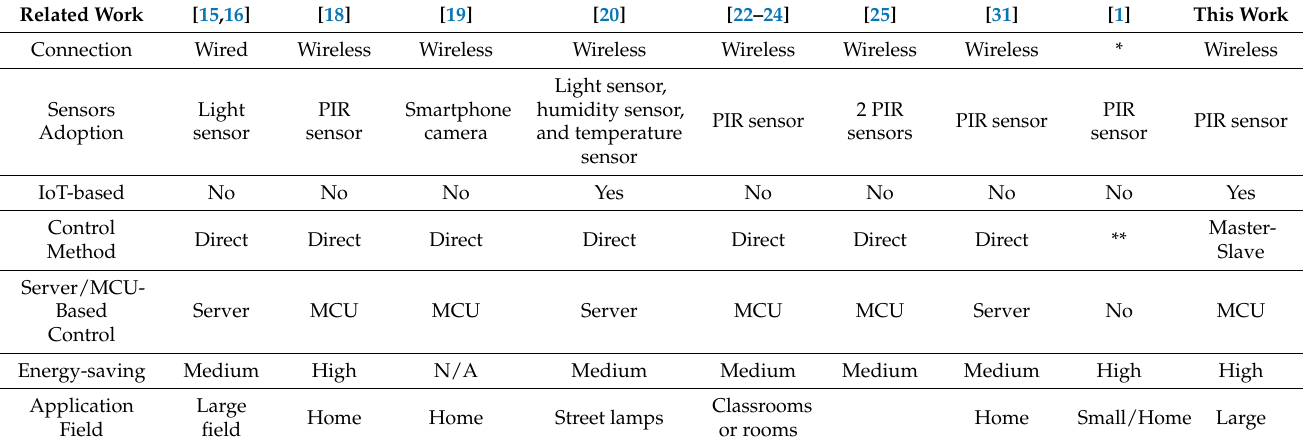
Table 1. A comparison of related works with the proposed system.